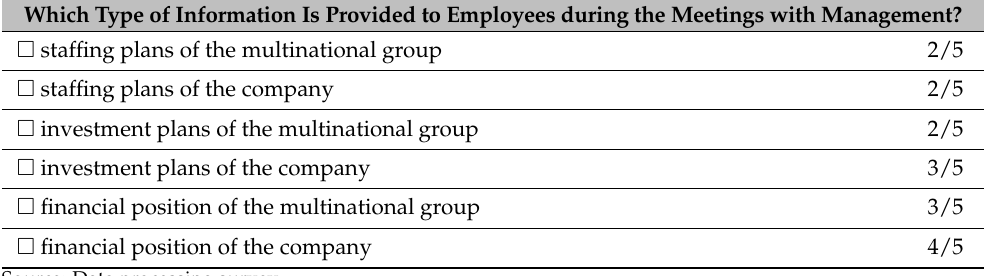
Table 5. The type of information provided to employees during the meetings with the